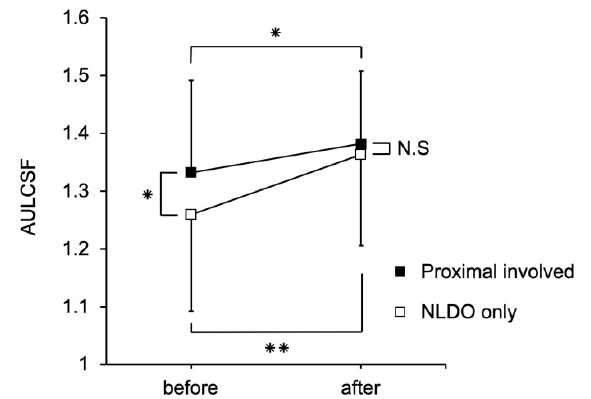
Figure 2. Changes and comparison of AULCSF in eyes with NLDO only and those with the involvement of proximal obstruction before and after LPI. The AULCSF improved significantly after LPI in both groups (NLDO only group, p < 0.001; proximal involvement group, p < 0.05). Before LPI, there was a significant di ff erence in AULCSF between the two groups ( p < 0.05); however, the di ff erence became insignificant after LPI ( p = 0.32). Values are expressed as the mean ± standard deviation. LPI, lacrimal passage obstruction; AULCSF, area under the log contrast sensitivity function; NLDO, nasolacrimal duct obstruction. * p < 0.05, ** p < 0.001 There were no significant differences in TMH or TMA between the two groups before and after